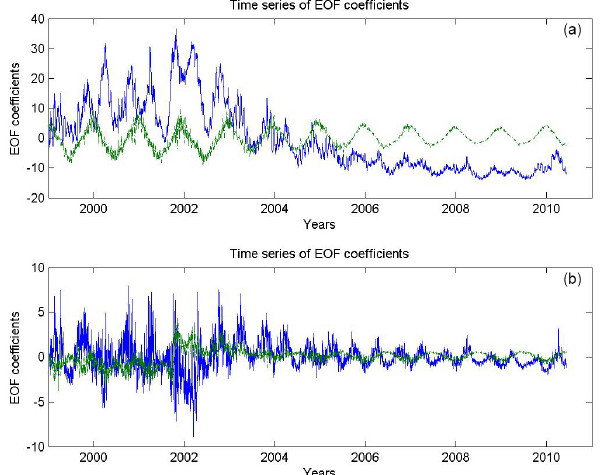
Figure 11. Differences in TEC time series between those shown in Fig. 10 and the ones calculated based on highly truncated expansion Eq. (2) with M = 4 at five different latitudes: 0 ◦ , 37.5 ◦ S, 37.5 ◦ N – blue, green, red lines in panel (a) ; 62.5 ◦ S, 62.5 ◦ N – green, red lines in panel (b) .